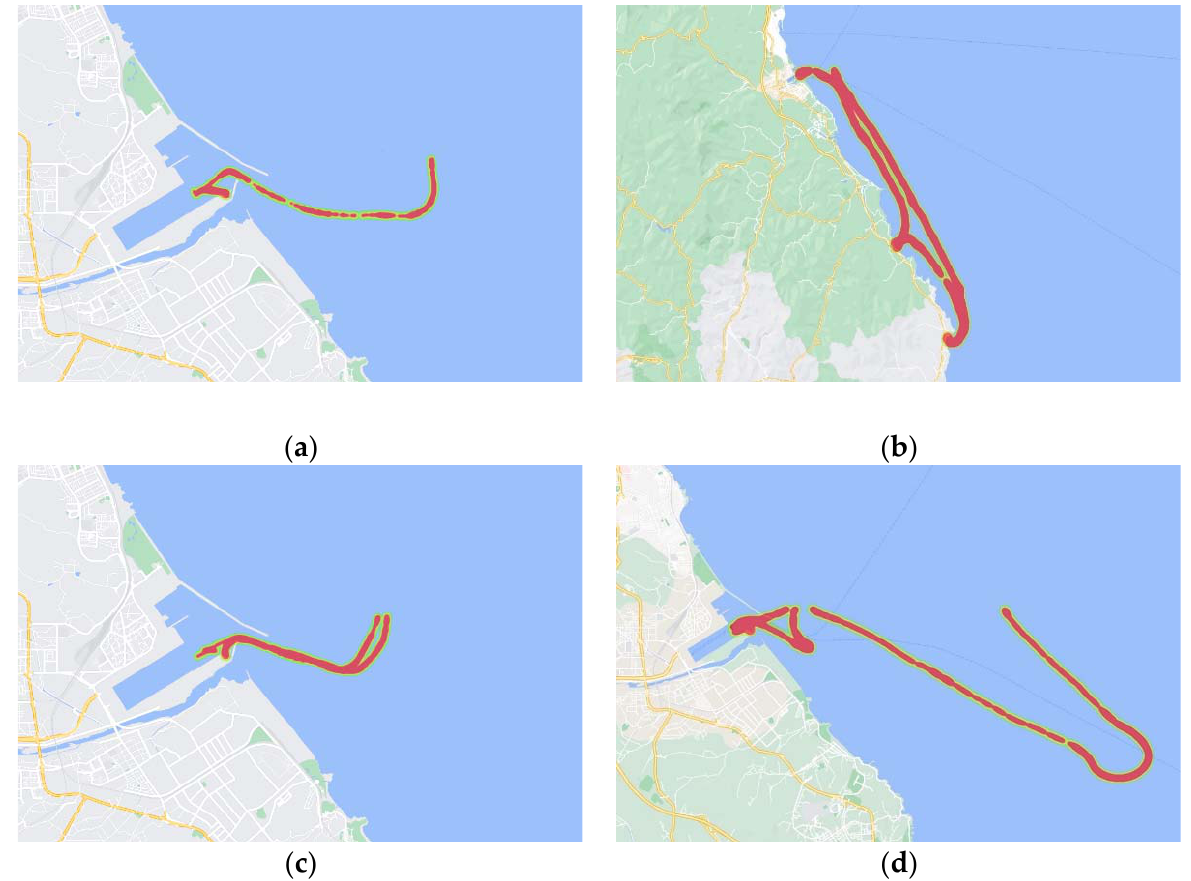
Figure 9. Examples of voyage trajectories in the operational profiles. ( a ) Trajectory of operational profile 1; ( b ) trajectory of operational profile 2; ( c ) trajectory of operational profile 3; ( d ) trajectory of operational profile 4.